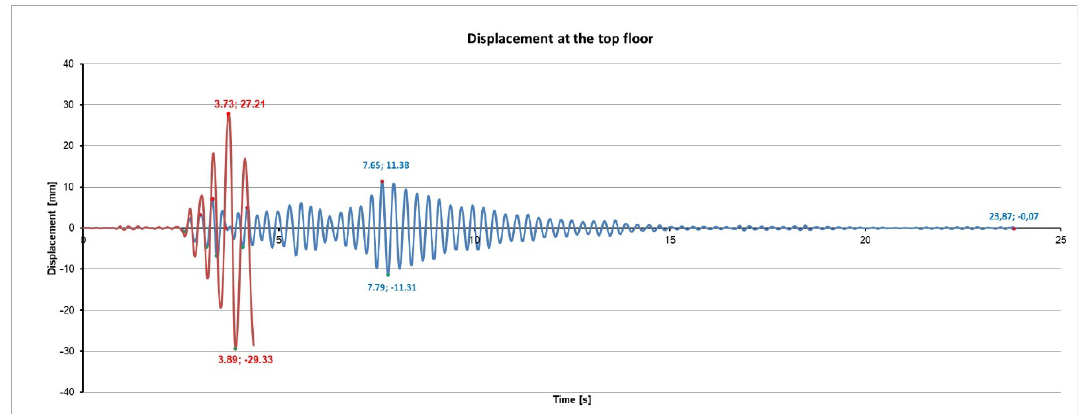
Figure 11. Displacement of the node 44014 at the top floor due to action of 0.1 g (indicated by a blue color) vs 0.2 g scaled accelerogram (indicated by the red